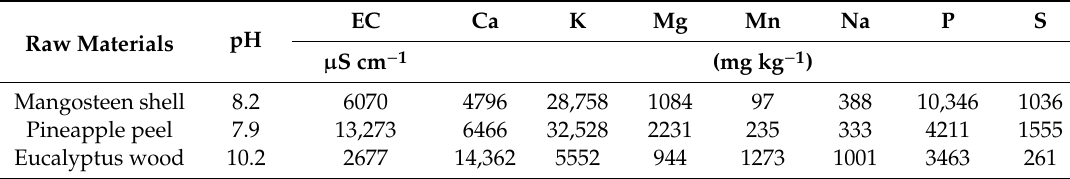
Table 3. The pH, EC, and total element concentrations of biochars a .